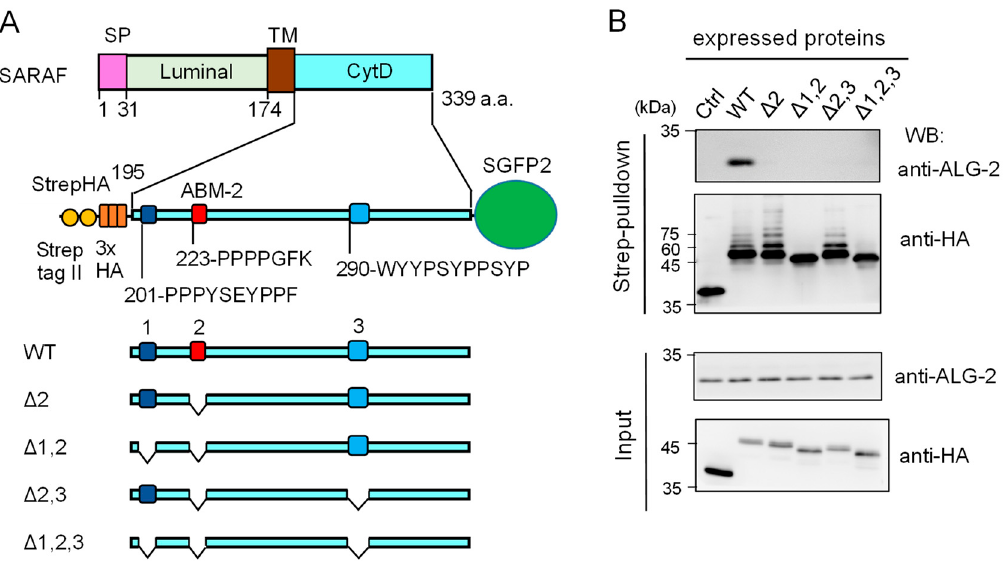
Figure 4. Deletion mutation of the SARAF cytosolic domain (CytD) a ff ecting ALG-2 binding and ubiquitination. ( A ) Schematic diagram of the SARAF CytD, which contains three distinct motifs rich in Pro and aromatic residues (designated regions 1, 2 and 3). Expression plasmids for the SARAF CytDs of WT and various deletion mutants that were fused with Strep-tag II and 3xHA (StrepHA) at the N -terminus and SGFP2 at the C-terminus were constructed. ( B ) Strep-pulldown assay. After HEK293 cells had been transfected with pStrepHA-SARAF_CytD-SGFP2 (WT and deletion mutants) and cultured for 24 h, the cells were lysed with lysis buffer HKM containing protease inhibitors, 0.2% Nonidet P-40 and 10 µ M CaCl 2 . The cleared cell lysates ( Input ) were subjected to Strep-pulldown followed by WB with anti-ALG-2 and anti-HA as indicated.